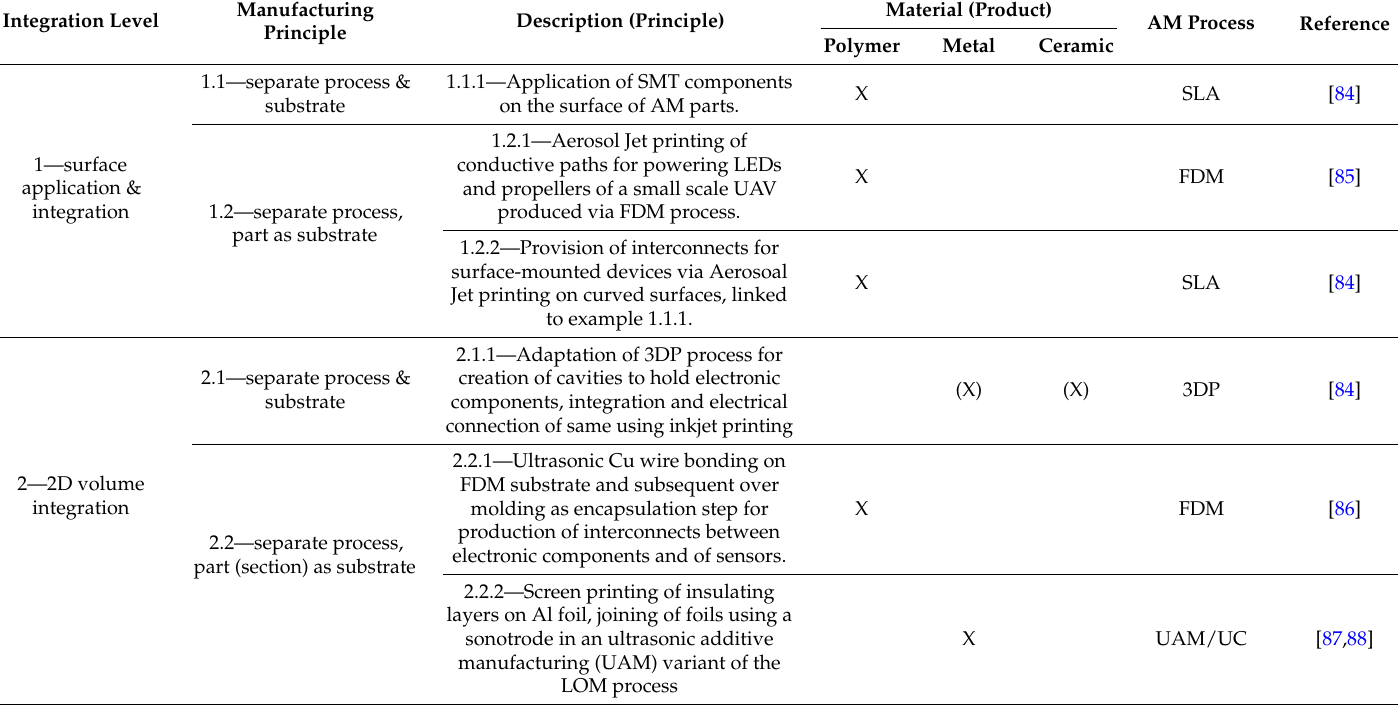
Table 2. Exemplary case studies on AM products with integrated or applied sensors, sensors systems, PEIDs